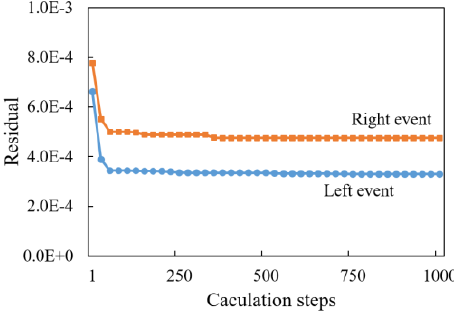
Figure 14. Search process for the residual value of the PSO optimal sample. The calculation results of the residual error of the right and left event finally tend to be stable.